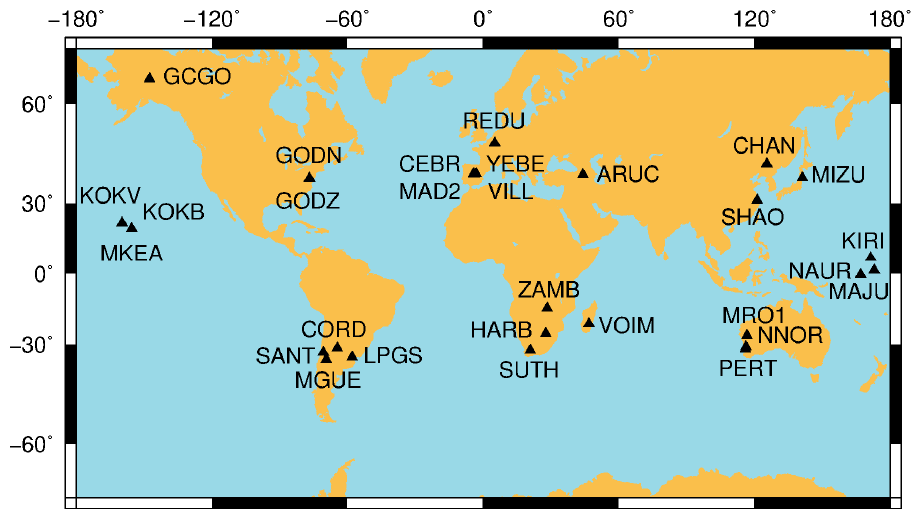
Figure 1. Distribution of sites that are used for this study.